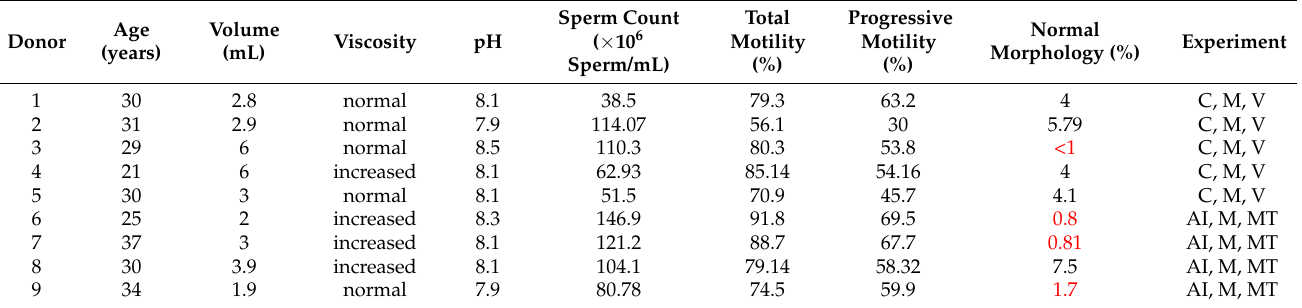
Table 1. Parameters of the semen samples included in the study, information from the donors, and the experiments for which they were